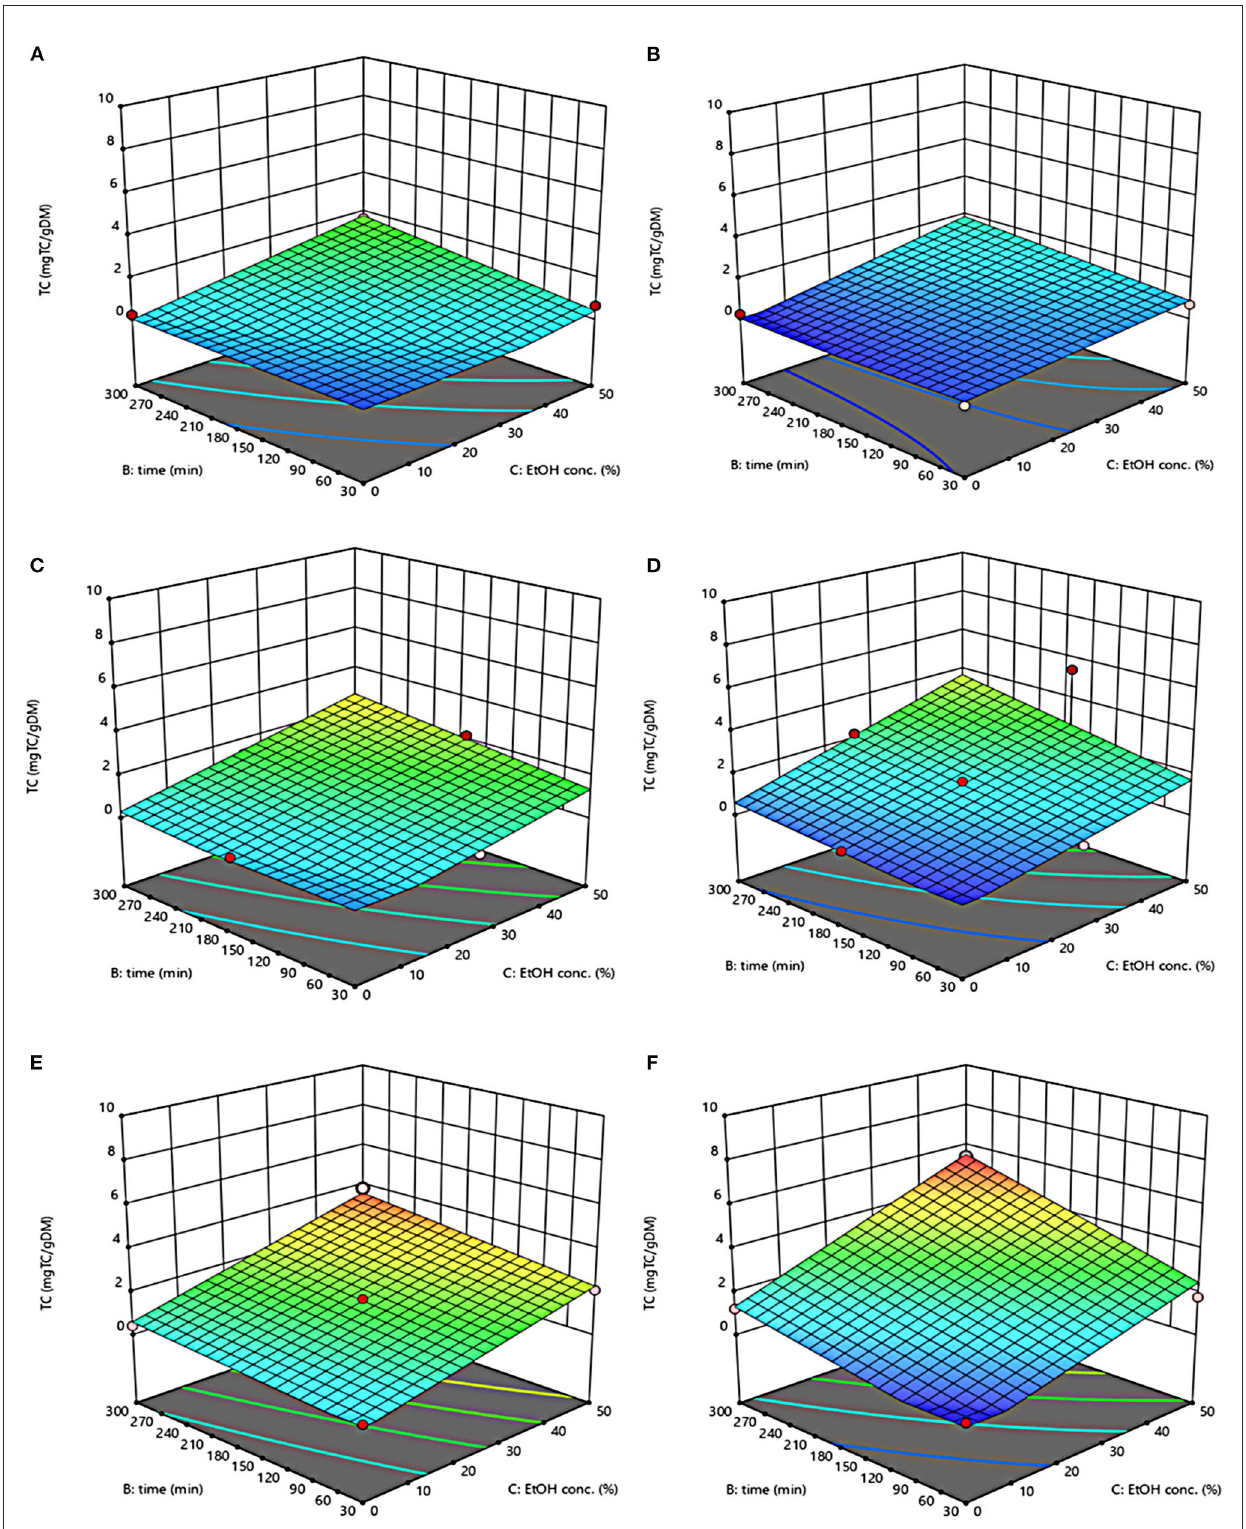
FIGURE5 Response surfaces of Tannin Content (TC) of extracts from untreated (Control) (A, C, E) and PEF-treated (E = 4.6 kV/cm; WT = 20kJ/kg) (B, D, F) grape pomace as a function of extraction time and ethanol concentration. Extraction temperature set at 20 ◦ C (A, B) , 35 ◦ C (C, D) , 50 ◦ C (E, F) .